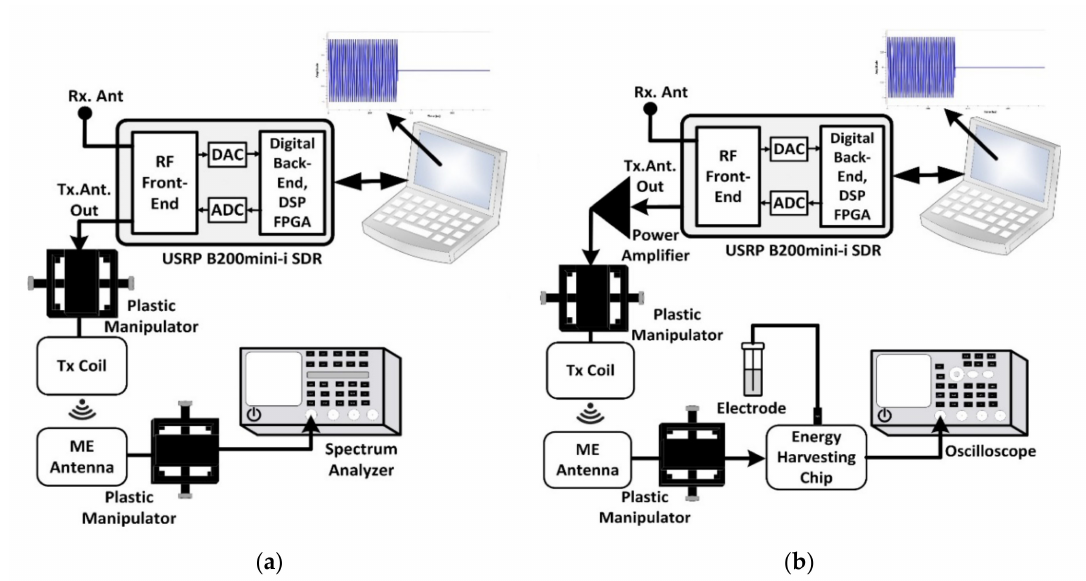
Figure 4. Experimental setup for energy harvesting with an ME antenna excited by the SDR: ( a ) test arrangement for power transfer e ffi ciency (PTE) measurements; ( b ) test arrangement to characterize